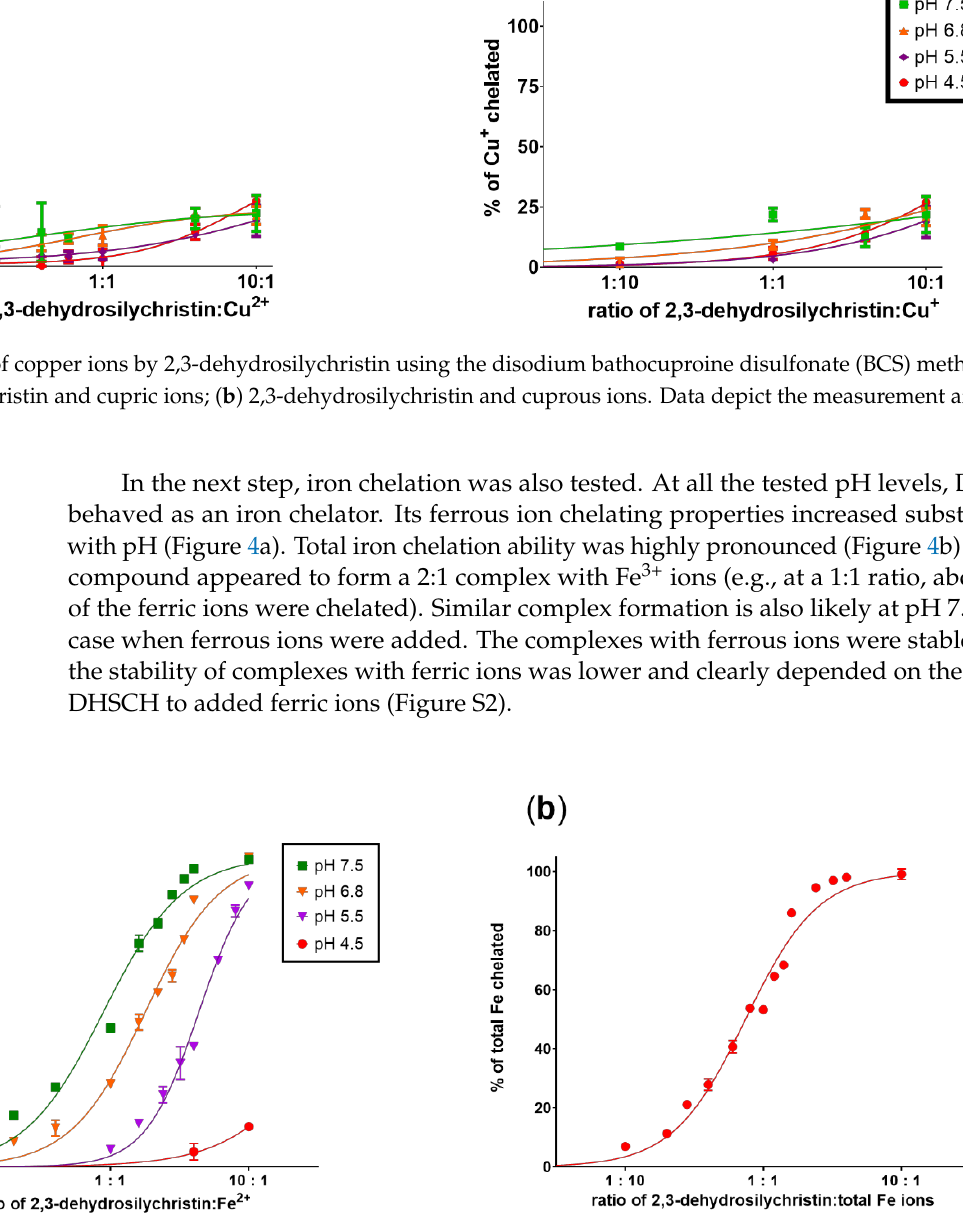
Figure 4. Iron-chelating properties of 2,3-dehydrosilychristin: ( a ) chelation of Fe 2+ ; ( b ) total iron chelation. Data depict measurement after 5 minutes.